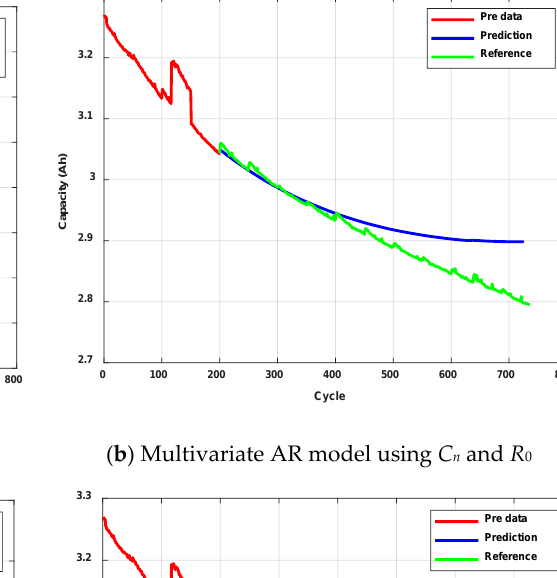
Figure 11. Capacity prediction results obtained using the autoregressive (AR) model and the measured capacity.